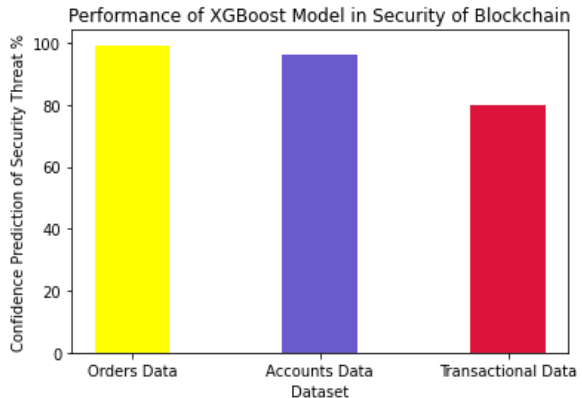
Figure 8. Performance of XGBoost in securing the blockchain